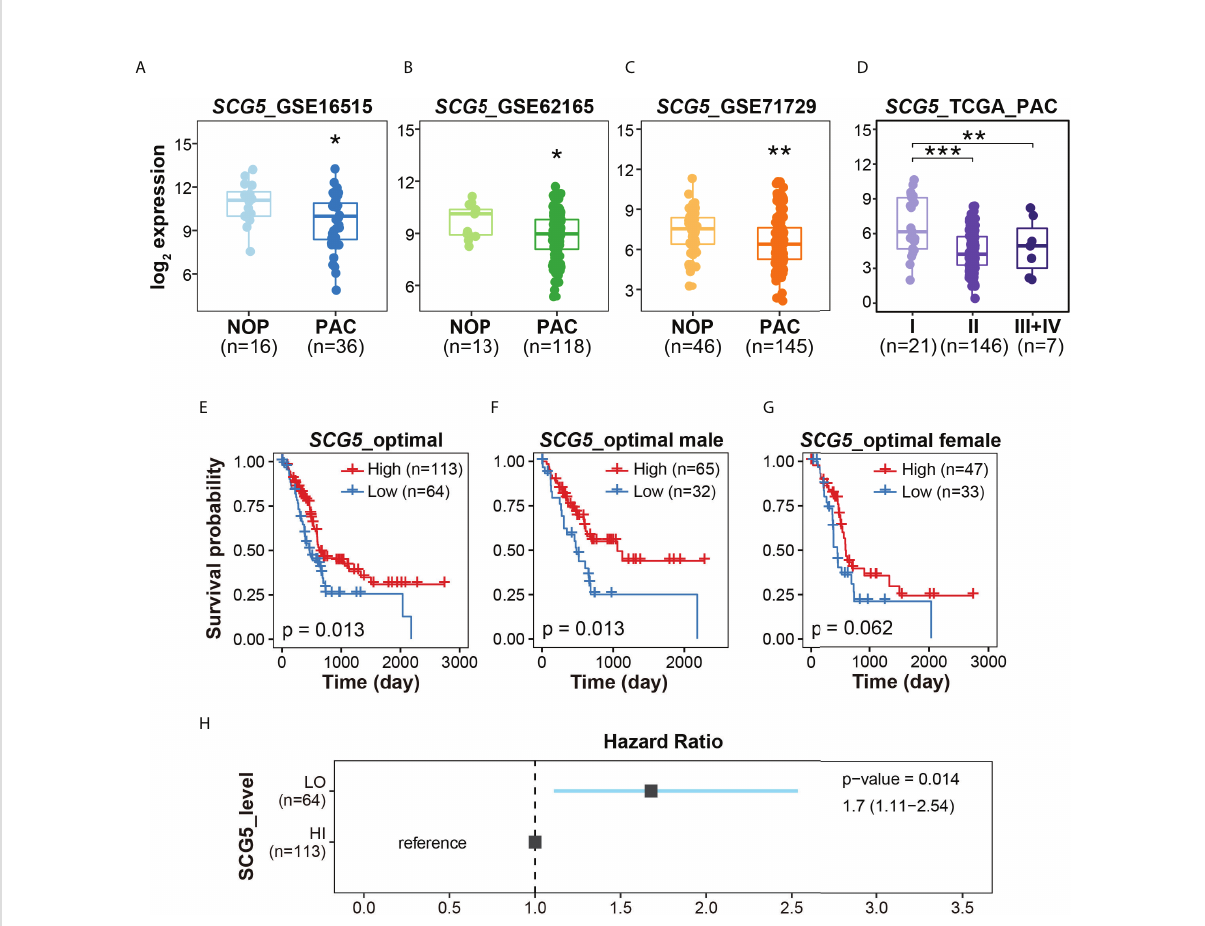
FIGURE 3 The expression pro fi les and clinicopathological signatures of Secretogranin V ( SCG5 ). (A – C) Box plots presenting the levels of SCG5 transcript in NOP and PAC. (D) Box plot showing SCG5 expression at each stage of PAC. The boxplots (A – D) present the 25% quartile, the median, and 75% quartile. Student ’ s t- test (A – C) and one-way ANOVA (D) determined the statistical signi fi cance. ***p < 0.001; **p < 0.01; *p < 0.05. (E – G) Kaplan – Meier curves for overall survival of patients with PAC from TCGA cohort. (H) The forest plot showing the hazard ratio and 95% con fi dence intervals associated with the SCG5